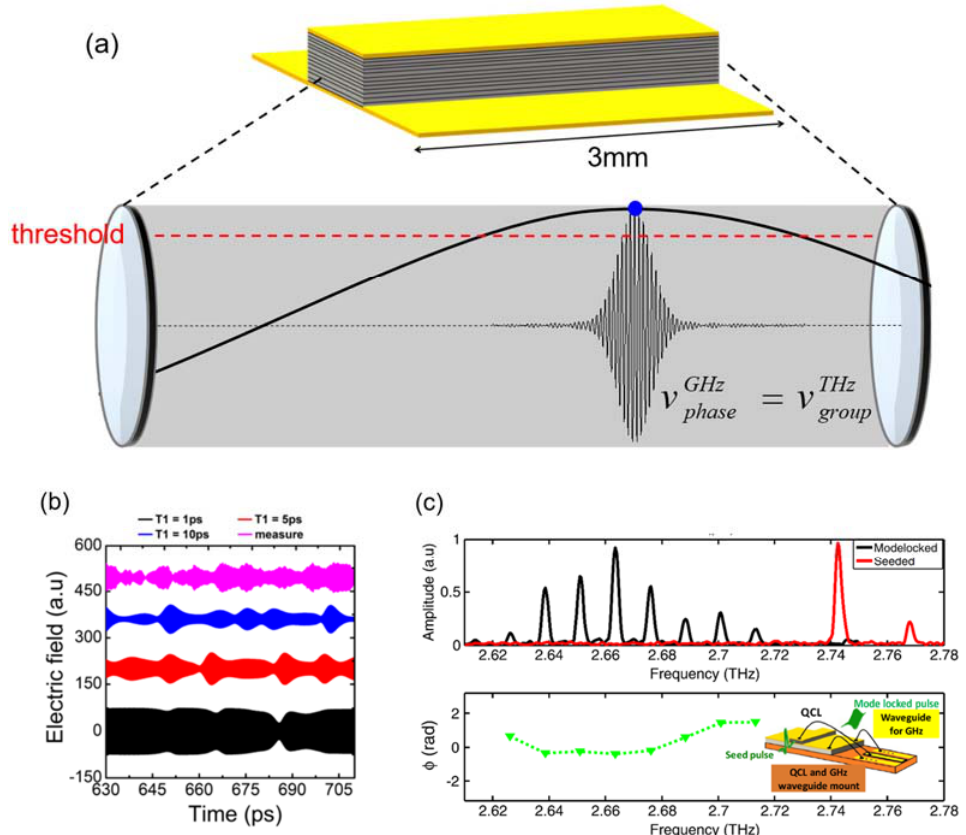
Figure 8. ( a ) The schematic of mode-locking mechanism of QCLs. ( b ) The Maxwell–Bloch simula- tions of the gain recovery time: Calculated time-domain profiles of QCL output emission over one round-trip period for gain recovery times of 1 ps (black), 5 ps (red) and 10 ps (blue curve). The magenta curve corresponds to experimental data. ( c ) Top: the spectra of a seeded (red) and a mode-locked (black) QCL, bottom: the phases of the eight mode-locked longitudinal modes (green triangles). Inset: QCL schematic showing the device integrated with a microwave waveguide for active mode-locking and illustrating the input seed pulse and the seeded/mode-locked output. (Figures from Ref [23], reprint with the permission of Optica publishing group).